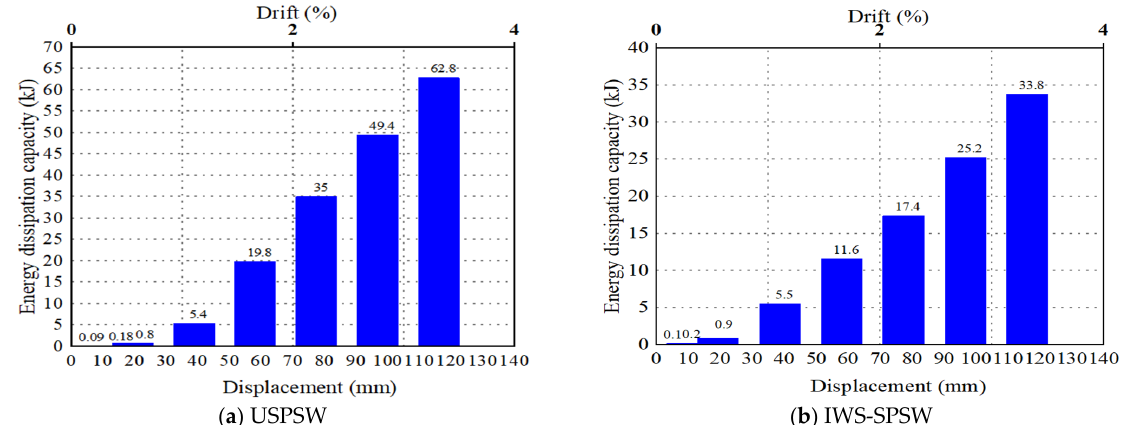
Figure 11. Calculative method of energy dissipation capacity of the hysteresis curve.